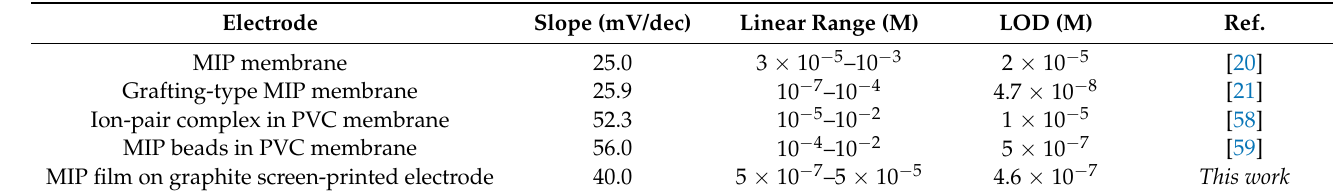
Table 1. Comparison with other potentiometric methods for atrazine detection.